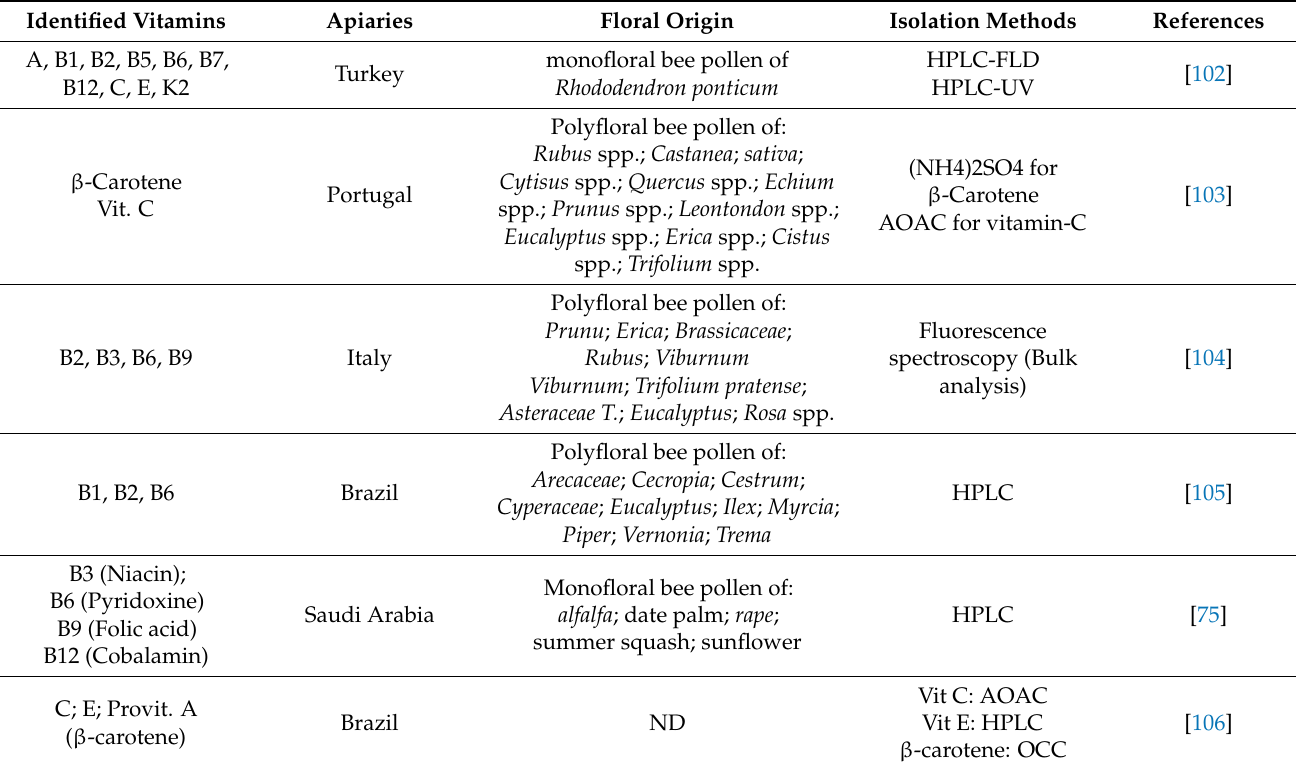
Table 1. Summary of the different vitamins isolated from bee